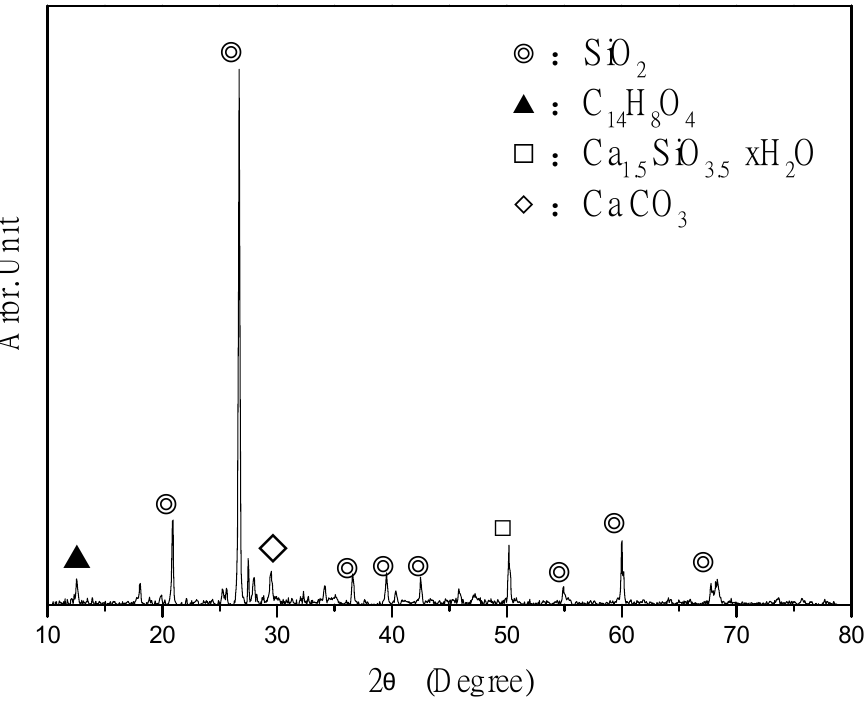
Figure 17. Chemical composition of ICM 5 mm below the coating layer, as determined through XRD.